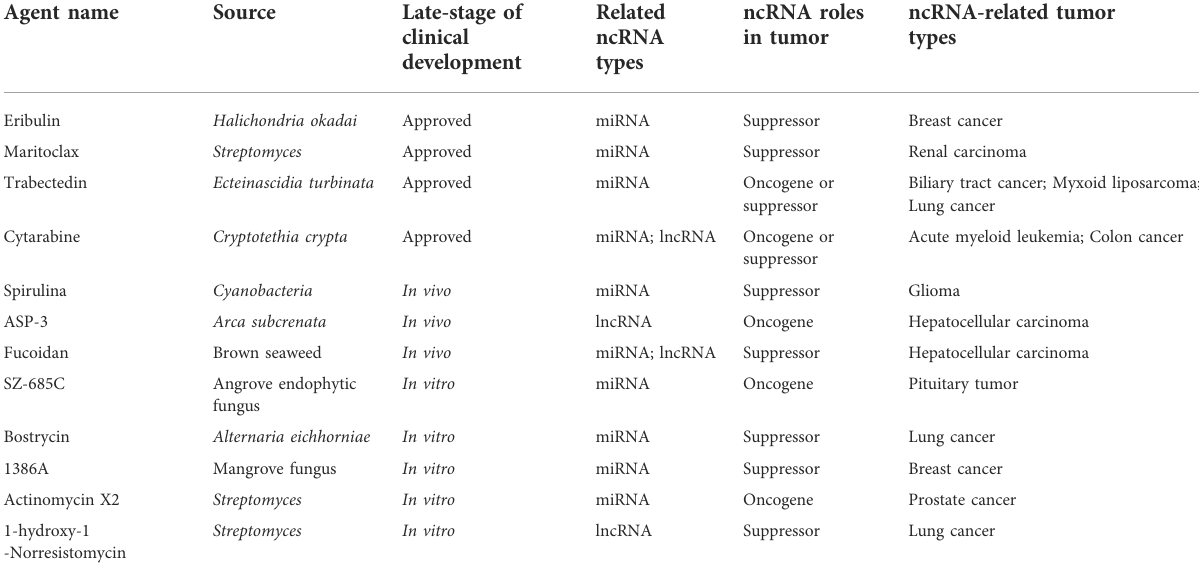
TABLE 3 ncRNA-associated marine-derived anti-tumor